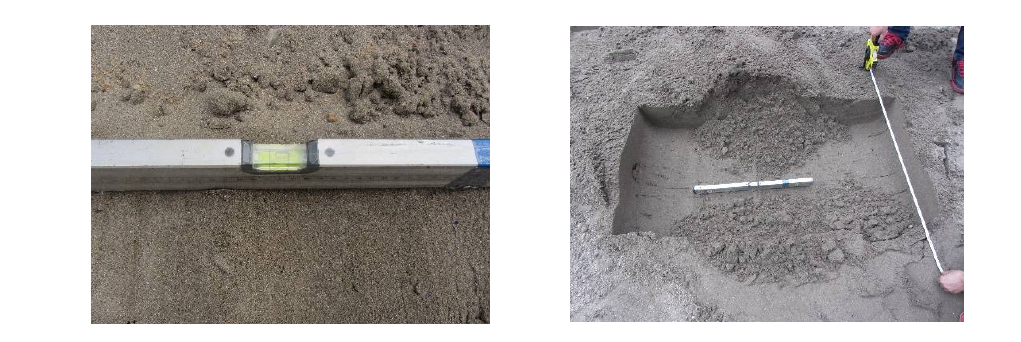
Figure 19. Level measurement method.